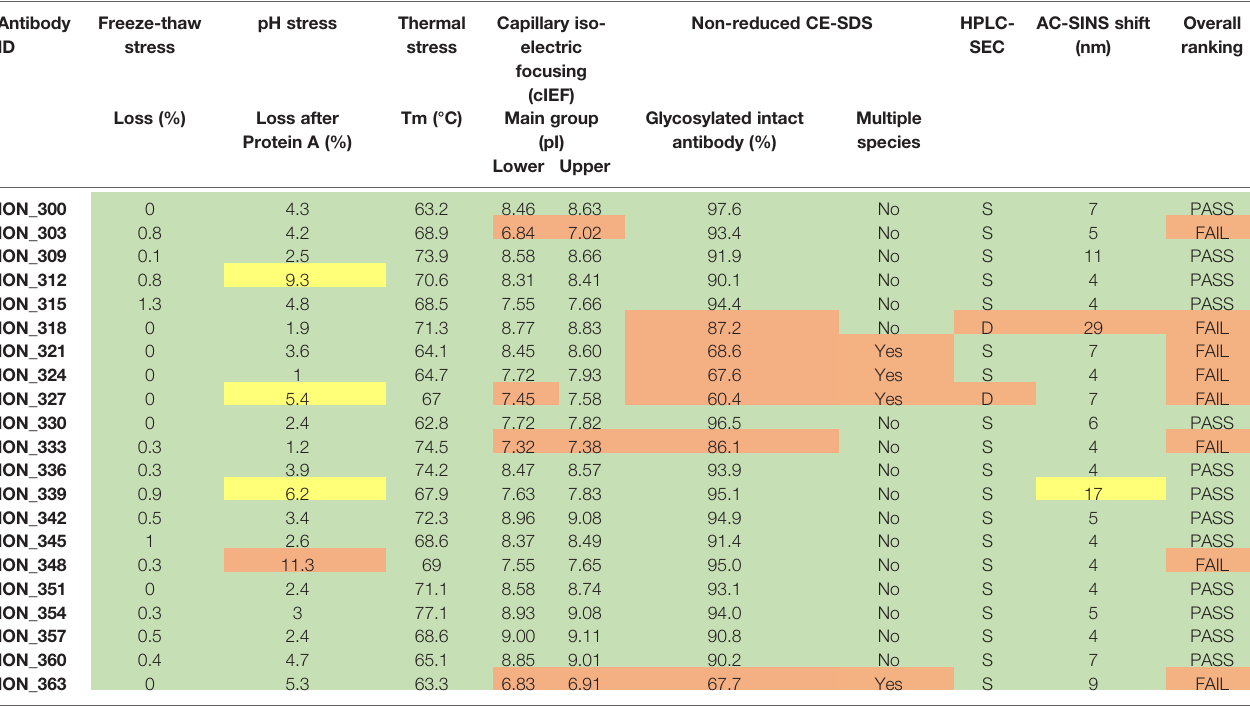
were given a green fi ll color; antibodies that failed the criteria set were given an orange color. A yellow fi llcolor was given where antibodies were considered weaker but were not classi fi ed as failed. An overall developability pass or fail ranking was given based on all